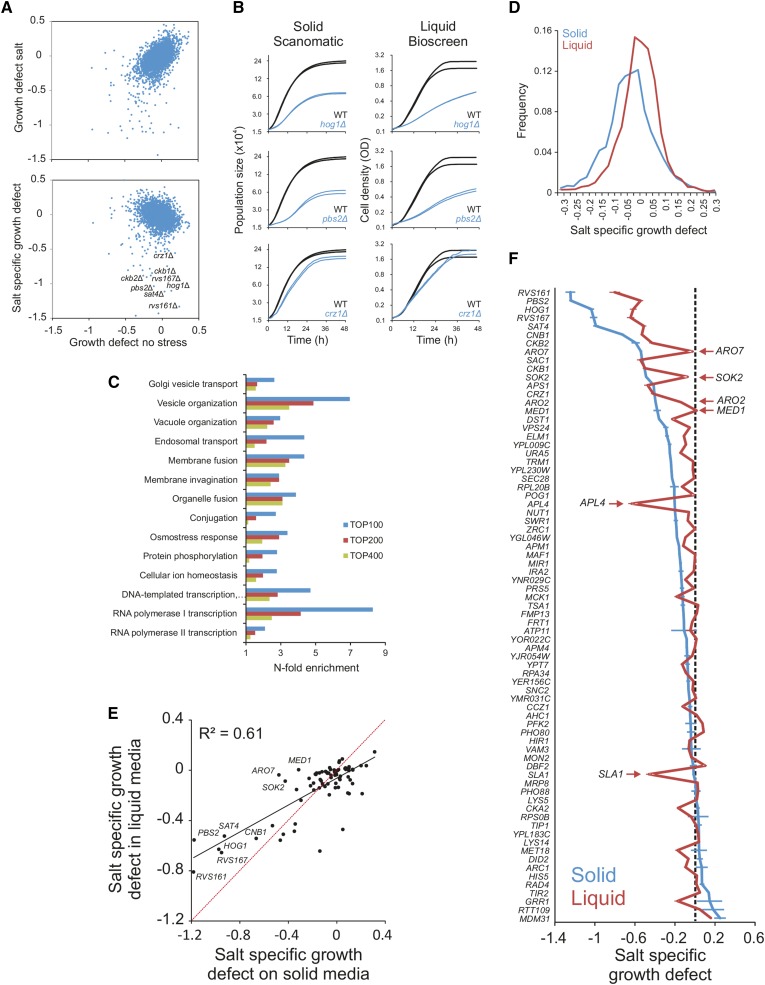
Recapitulating and extending the known salt biology with Scan-o-matic. The haploid MATα yeast deletion collection (BY4742) was cultivated in 2% glucose, with and without 0.85 M NaCl. Log2 population doubling times relative the control surface of WT controls were extracted. Negative values represent growth defects. (A) Upper panel: comparison of relative population size doubling times of the yeast deletion collection in presence and absence of NaCl. Lower panel: colony population doubling times in NaCl were normalized to corresponding measures in absence of NaCl, estimating NaCl-specific growth effects. These were plotted as a function of relative population doubling times in the absence of NaCl. Little correlation remains. (B) Growth dynamics of three sample deletion strains (n = 2) with NaCl-specific growth defects, in Scan-o-matic and during liquid microcultivation. (C) Functions enriched (Fisher’s exact test, false discovery rate, q < 0.05) among the top 100, 200, and 400 most salt sensitive deletion strains in Scan-o-matic. Cut-offs approximately correspond to relative growth defects larger than −0.27, −020, and −0.15. (D) Frequency distributions of salt-specific deletion strain growth effects, obtained by solid substrate cultivation in Scan-o-matic and by liquid microcultivation in a Bioscreen C (Warringer and Blomberg 2003). (E and F) A subset of 70 deletion strains, half of which were chosen to represent the most salt sensitive deletion strains detected in the global screen and half of which were chosen randomly, were recultivated in the absence and presence of 0.85 M NaCl at high replication, using Scan-o-matic (n = 24) and liquid (n = 6) microcultivation, respectively. Recultivations were performed in parallel (the same precultures) and in identical conditions, removing all conceivable systematic variation beside cultivation method. (E) Salt-specific growth defects in Scan-o-matic and liquid microcultivation regimes. Regression (black, Pearson R2 is indicated) and 1:1 lines (red) are shown. (F) Comparison of growth defects in mutants between agar and liquid growth. Deletion strains were ranked based on salt-specific growth effects during solid substrate cultivation and salt-specific growth effects were plotted for both conditions (solid and liquid). Error bars = SEM. NaCl, sodium chloride; WT, wild type.